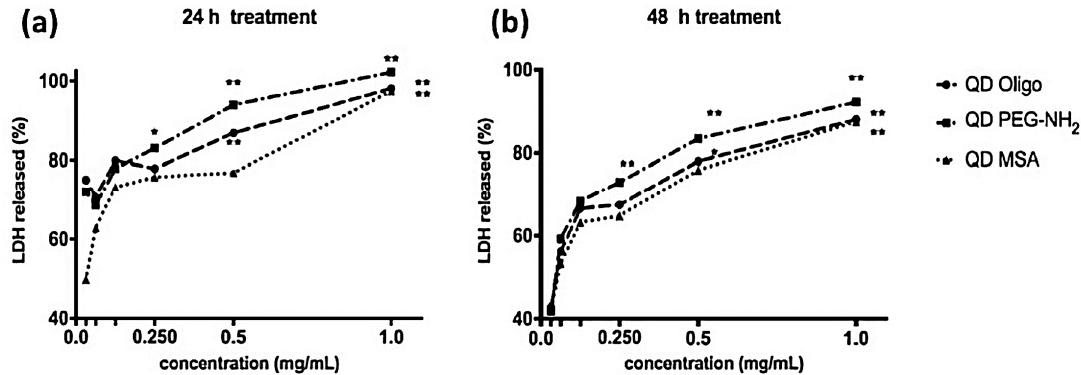
Figure 4. Percentage LDH release from RAW 264.7 cells treated with QDs with Oligo, PEG-NH 2 and MSA ligands at ( a ) 24 and ( b ) 48 h ( n = 3). Data is expressed as the % mean compared to positive control (0.1% Triton X-100) ± standard error of the mean. *( p < 0.05) and **( p < 0.01) indicate significant differences compared to control cells treated with completed medium only.